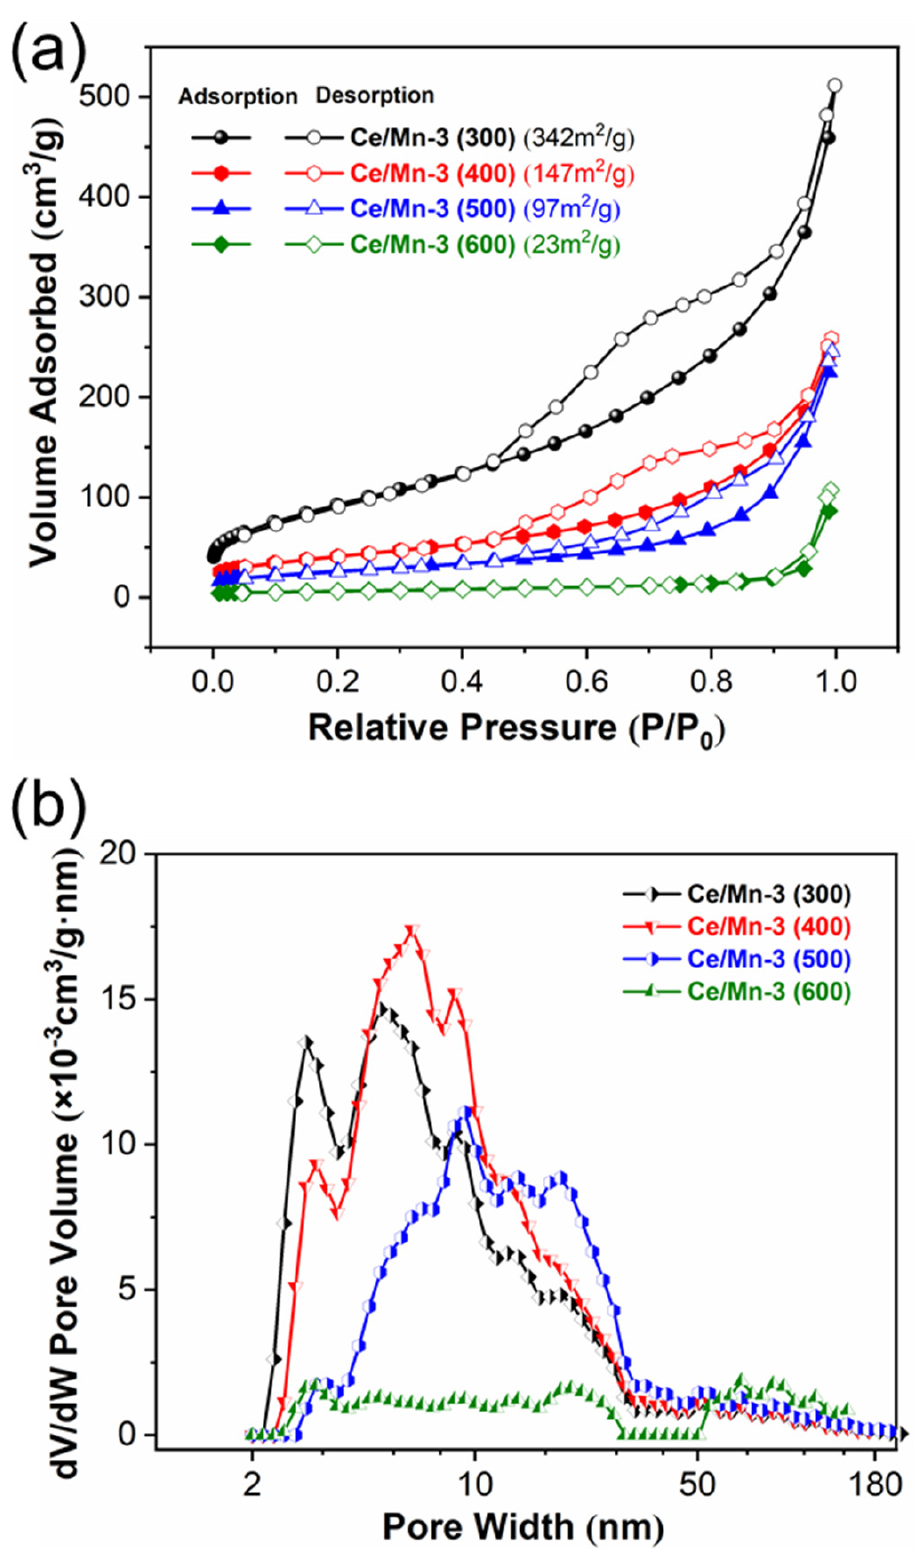
Figure 8. ( a ) N 2 adsorption–desorption isotherm and ( b ) pore size distribution of Ce/Mn-3 catalysts calcinated at different temperatures.